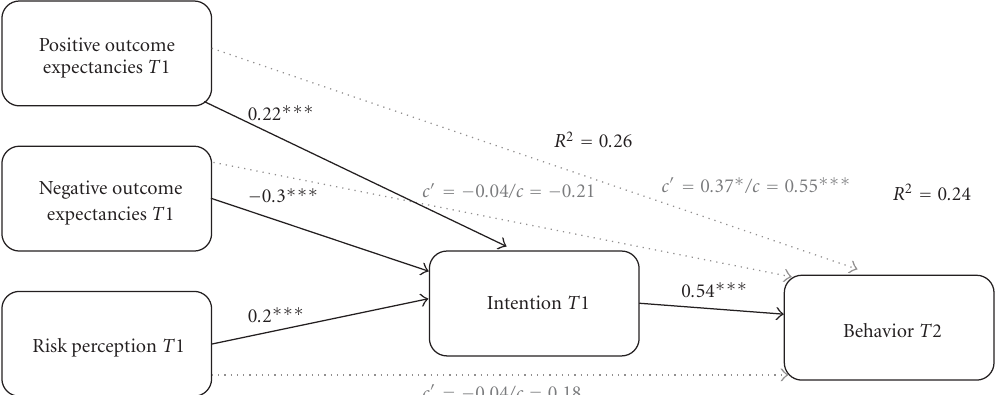
Figure 1: Mediation analysis ( N = 552). Indirect e ff ect of risk perception T 1, negative outcome expectancies T 1 on behavior T 2 via intention T 1. Partial mediation e ff ect for positive outcome expectancies T 1. Controlled for past behavior T 1. Note: ∗∗∗ P < . 001; ∗ P < . 05; c (cid:3) = direct e ff ect of independent variable on dependent variable; c = total e ff ect of independent variable on dependent variable.